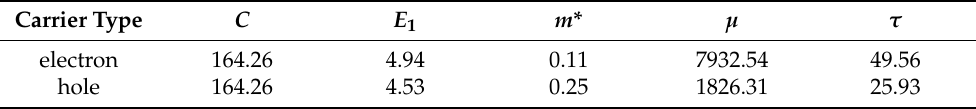
Table 3. In-plane elastic constant C (in N/m), deformation-potential constant E 1 (in eV), effective mass of carrier m * (in m e ), carrier mobility µ (in cm 2 /Vs), and carrier relaxation time τ (in 10 − 14 s ) of ID-GY at 300